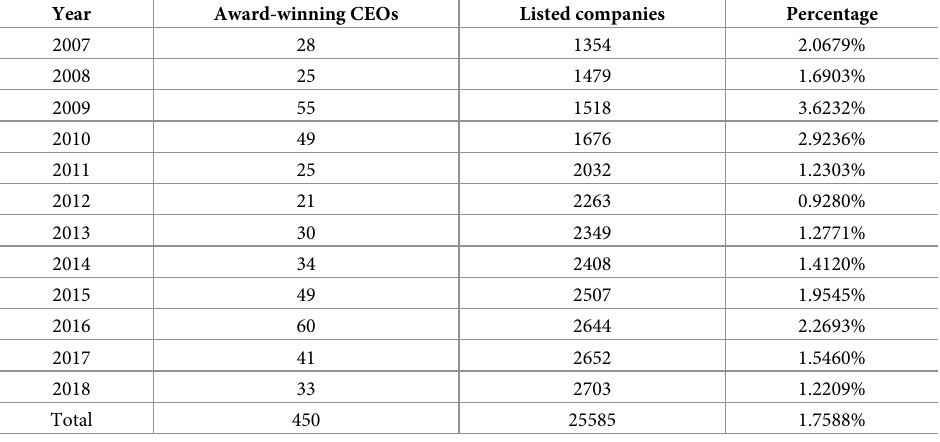
Table 1. Distribution of CEO